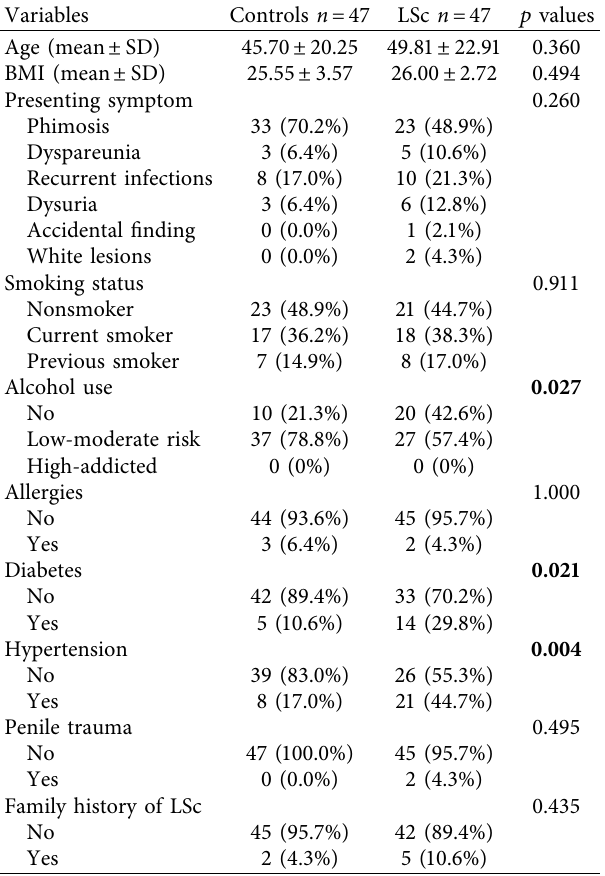
Table 1: Sociodemographic and behavioral characteristics, medical history, and presenting symptoms of study participants ( N �